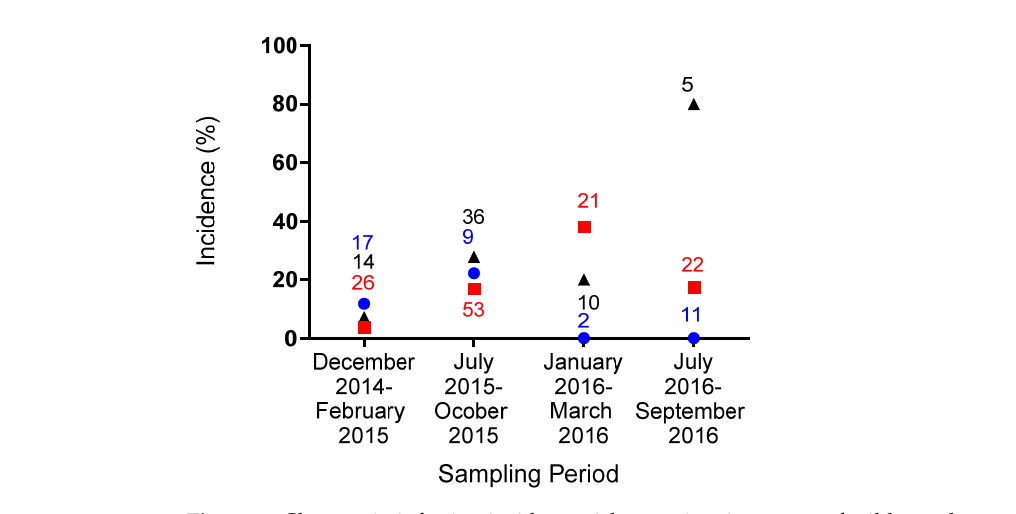
Figure 1. Changes in infection incidence risk over time in groups of wild meerkats receiving targeted or no vaccination. The number of new cases is expressed as a proportion of those eligible to be